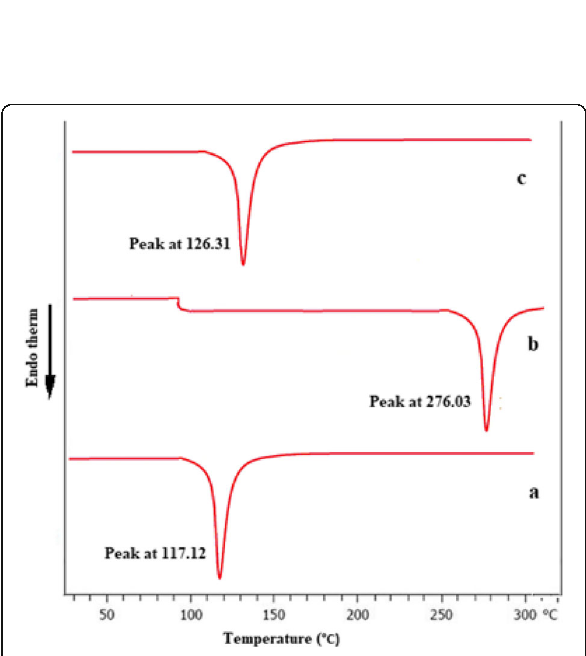
Fig. 4 a DSC thermogram of pure CAR. b DSC thermogram of pure HCT. c DSC thermogram of